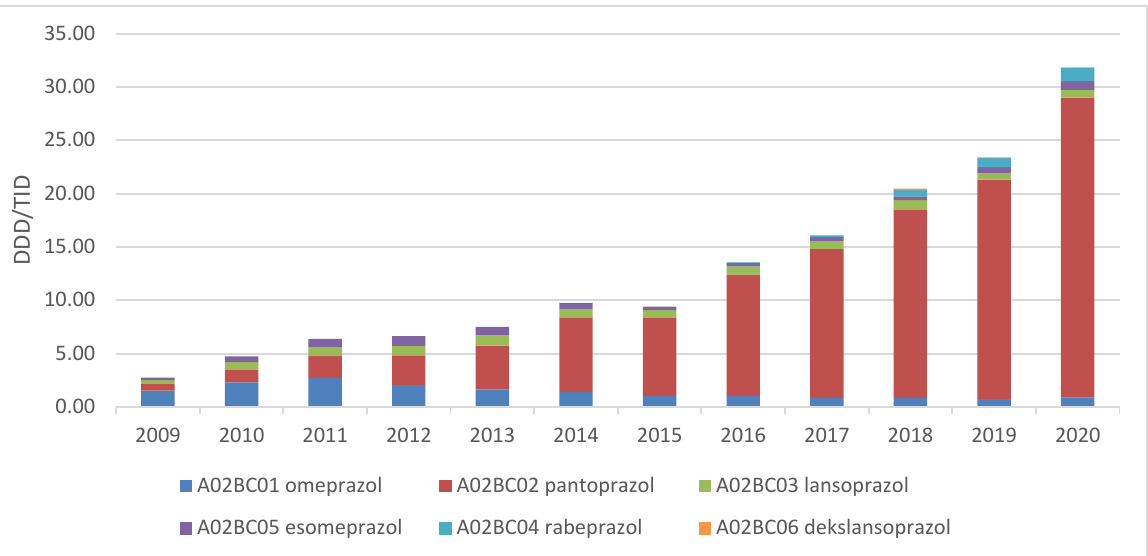
Figure 2. The utilization of proton pump inhibitors expressed in DDD/TID during the period 2009–